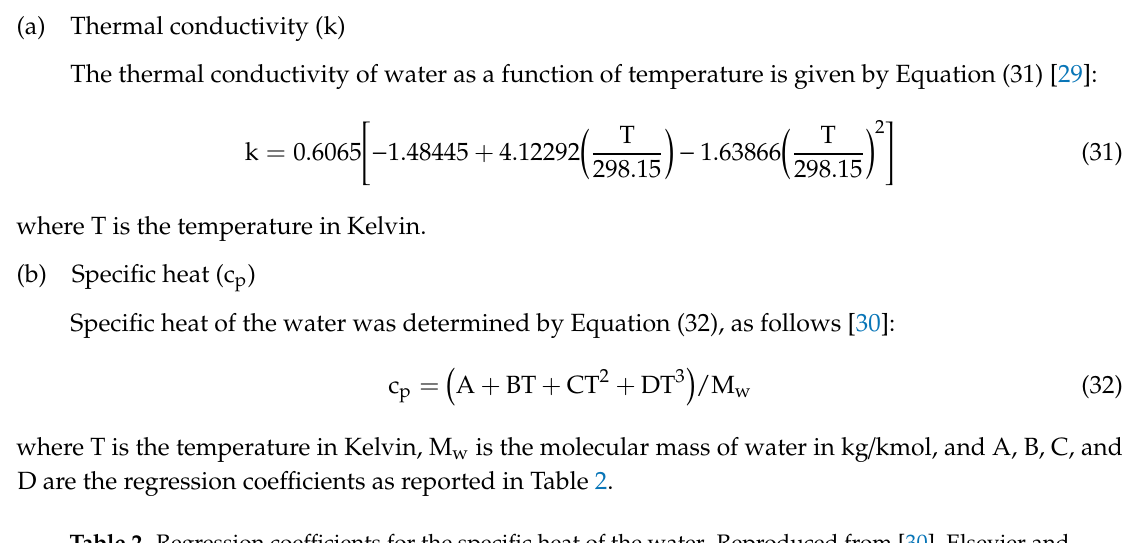
Table 2. Regression coe ffi cients for the specific heat of the water. Reproduced from [30], Elsevier and Gulf Professional Publishing: 2010.